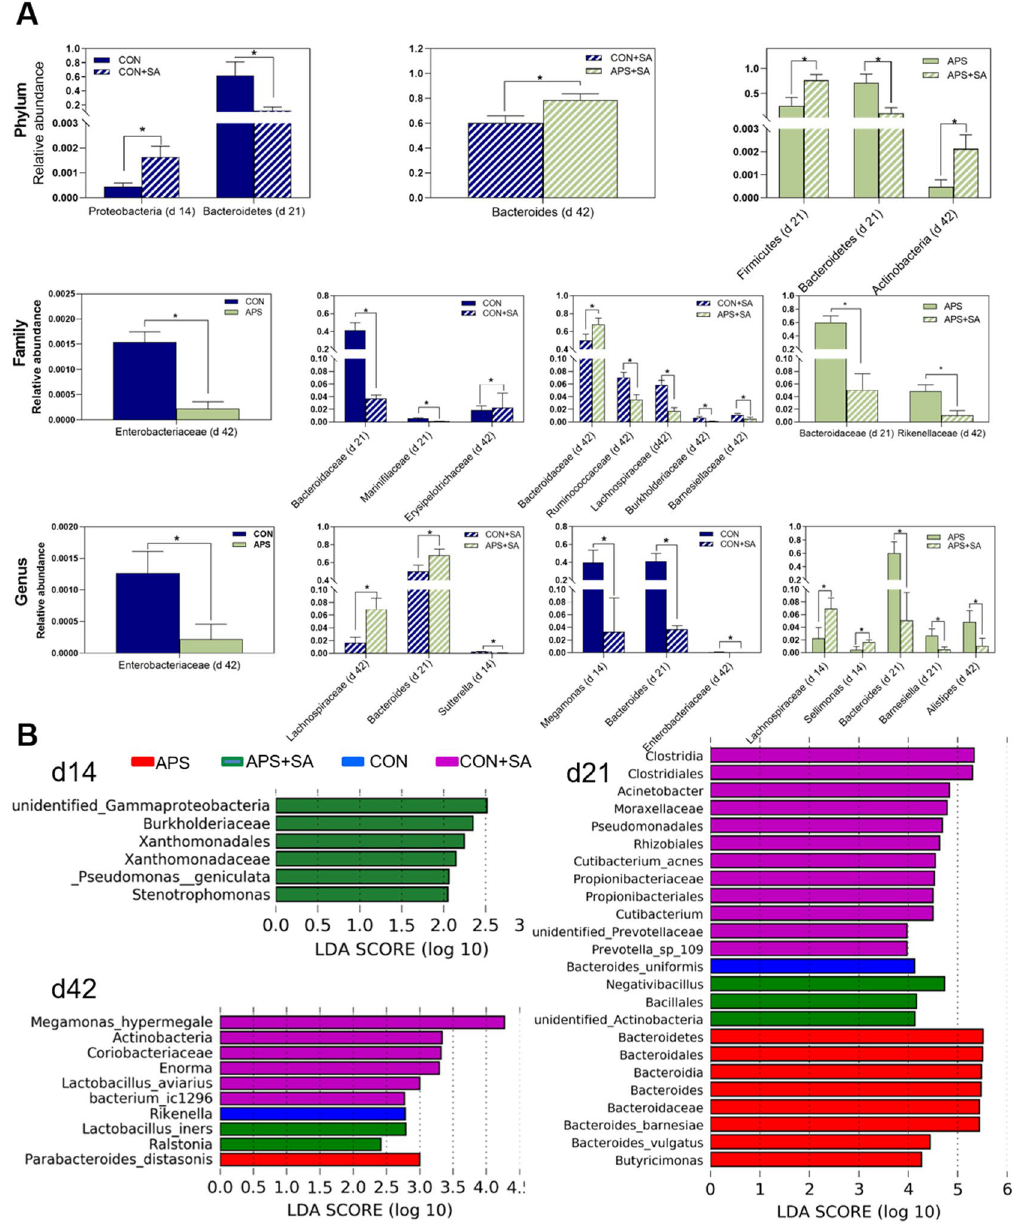
Figure 4. Cecal microbes with significant ( P < 0.05) discrepancies in abundance among the different groups. ( A ) Differences in abundance at the phylum, family, and genus levels. The x-axis shows the microbes at the phylum, family, or genus level, and the numbers in parentheses indicate the ages of the broilers, ( B ) LefSe analysis of the cecal microbial communities in broilers from the CON, APS, CON + SA and APS + SA groups at 14, 21, and 42 days of age. The LDA histogram shown the microbial species with significant ( P < 0.05) differences in different Correlations between core gut bacteria related to broiler body weight (BW) and treat - ment‑specific biomarker bacteria. To explore the correlations between intestinal microbes and phe- notypic outcomes, a co-occurrence network was created with BW as the targeted factor, and the core microbes directly correlated with BW in broilers receiving different treatments were identified. As shown in Fig. 6, some different types of bacteria were directly related to BW in the different treatments groups. Under conditions of no S. ser. Enteritidis infection, two core microbes, Odoribacter and Bacteroides , were identified in the broiler cecal microbiota to have abundance values positively correlated with broiler BW. Moreover, the two bacteria presented synergistic interactions with some biomarker bacteria (bacteria that differed among groups), such as Alistipes, Butyricimonas, and Barnesiella , which jointly promoted the growth performance of broilers. When the broil- ers were infected with S. ser. Enteritidis , the core microbes directly correlated with BW included Odoribacter , Bacteroides , Parabacteroides , Butyricimonas , and Synergistes . In non-APS-supplemented broilers, the bacteria